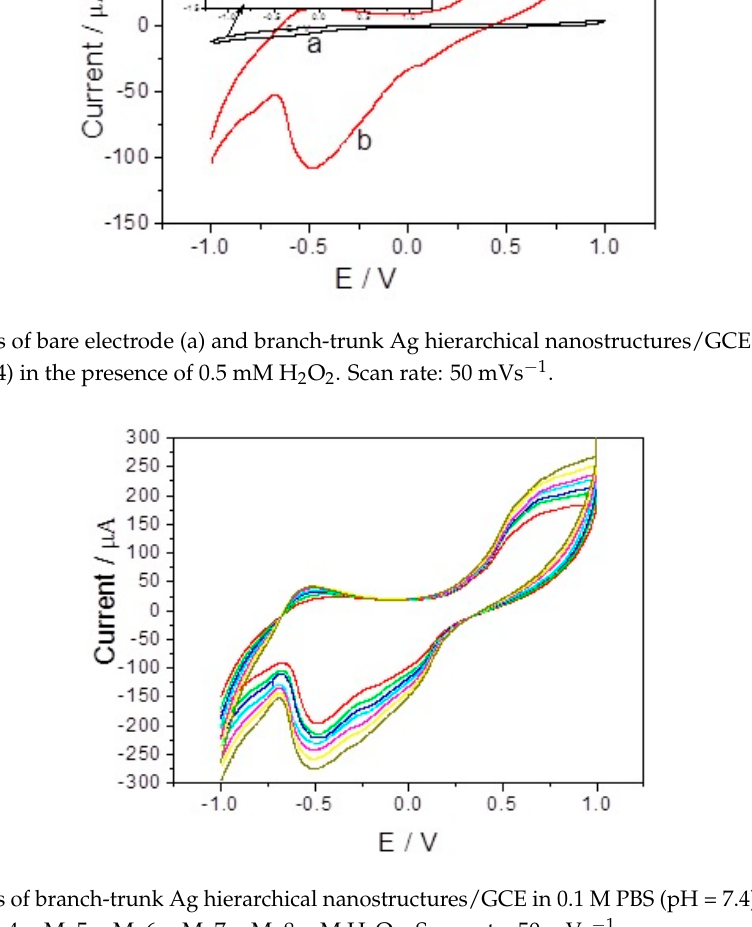
Figure 6. Amperometric response of the sensor for successive addition of H 2 O 2 in N 2 -saturated 0.1 M PBS (pH = 7.4) solution. The applied potential is − 0.5 V, (inset: a partial magnification of the current response toward a low concentration of H 2 O 2 solution).